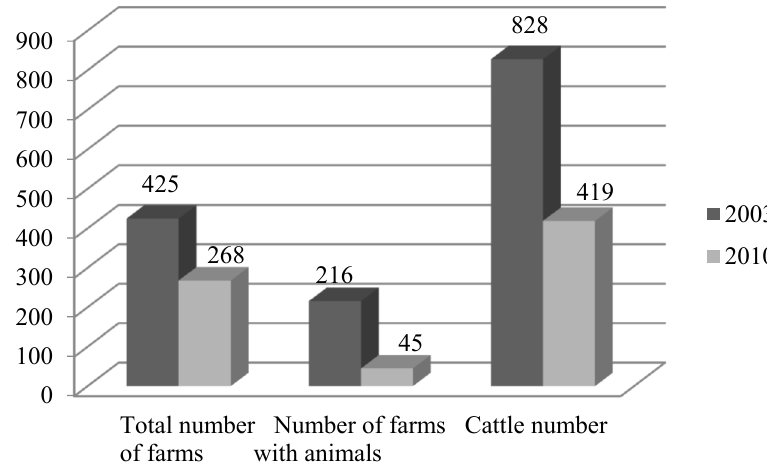
Figure 7. Total number of farms, number of farms with animals and the total number of cattle in all farms of Sendvaris ward from 2003 to 2010. Made using sources [27,28].